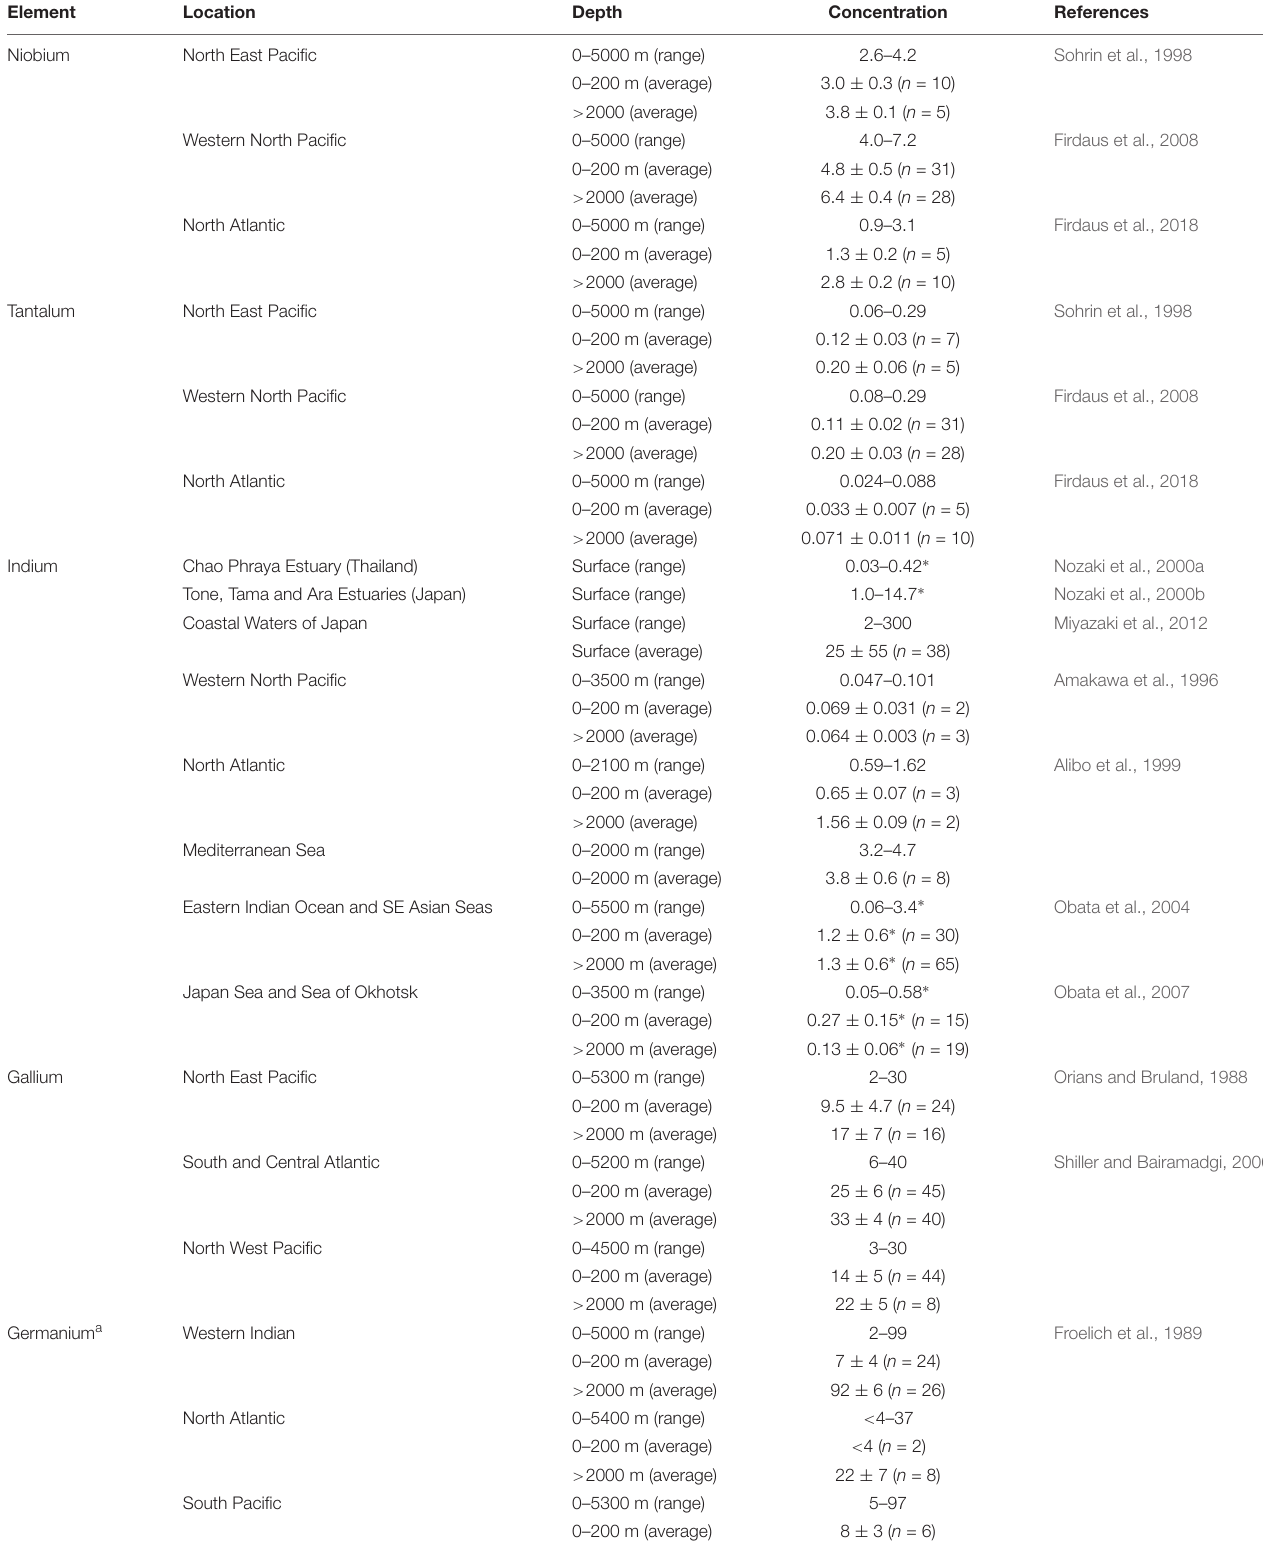
TABLE 1 | Concentrations (pmol/kg) of dissolved TCEs in natural seawater